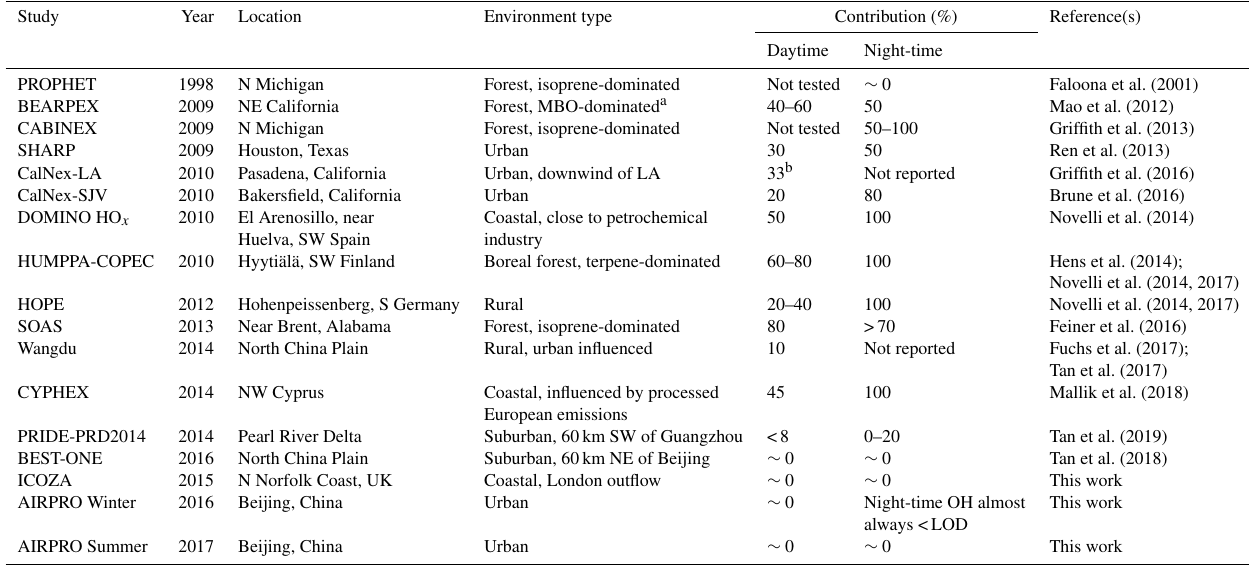
Table 4. Average contributions of FAGE background signals to the total OH measured ( = (OH wave – OH chem ) / OH wave ) during ambient air studies where a chemical modulation technique was